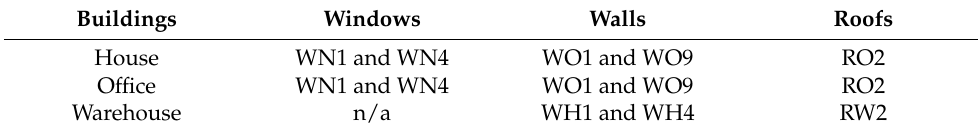
Table 12. Combinations used for LCCA.